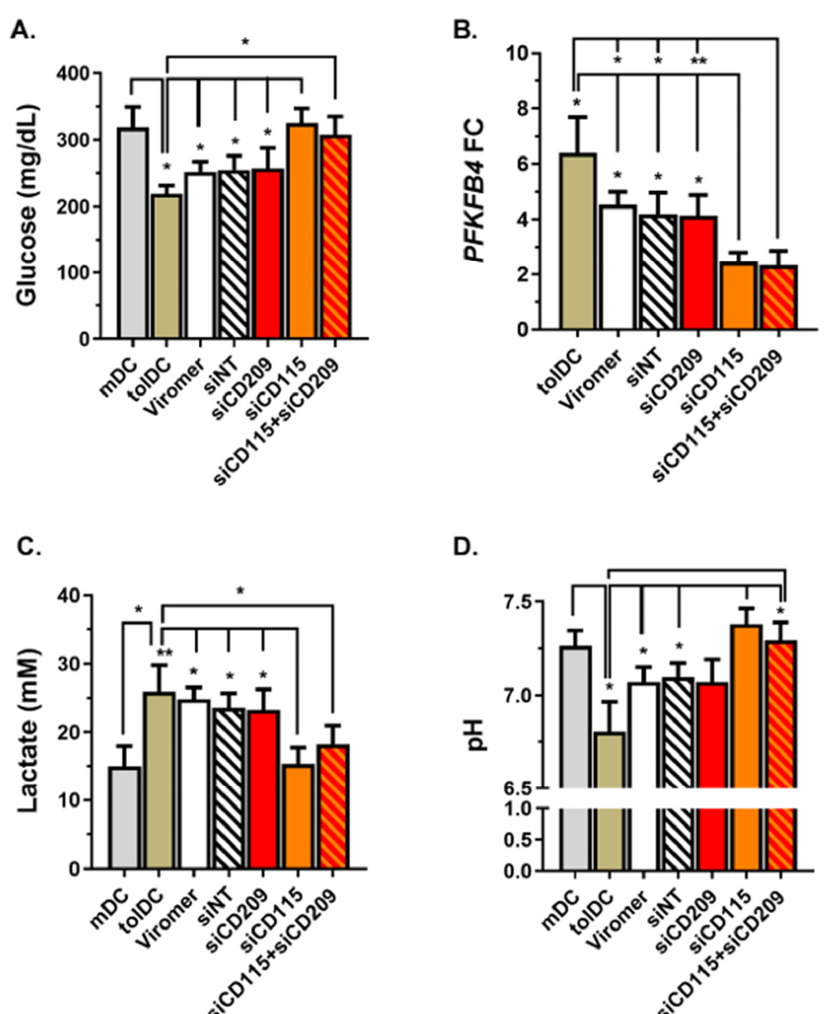
Figure 6. Role of CD115 in metabolism of VitD3-tolDC. Analysis of metabolic characteristics of mDC, VitD3-tolDC and VitD3-tolDC-treated siCD115 and/or siCD209 by determining glucose consumption ( A ), gene expression of 6-Phosphofructo-2-Kinase/Fructose-2,6-Biphosphatase 4 ( PFKFB4 ) in cells ( B ), secretion of lactate ( C ) and pH ( D ) of supernatants on day 6 of culture. Data shown as mean + SEM. For glucose concentration, pH and lactate, n = 3 (except for mDC and tolDC groups, n = 5). For PFKFB4 gene expression analysis, n = 4. * p < 0.05; ** p < 0.01.